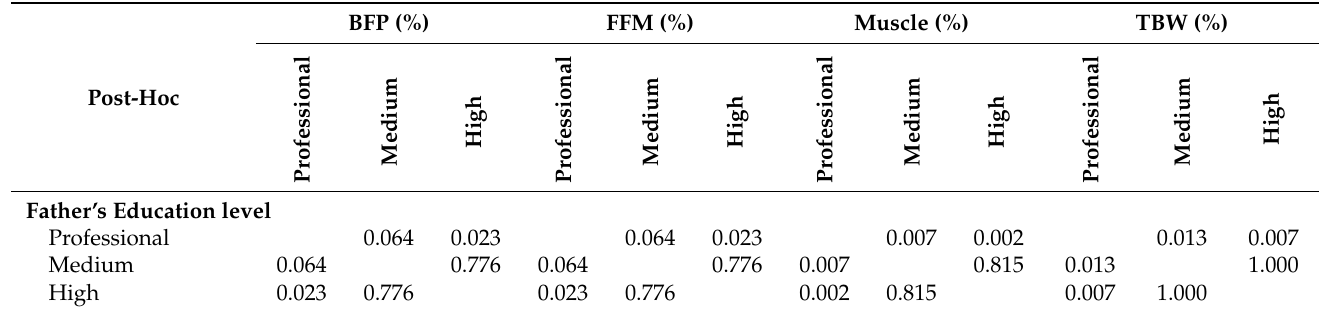
Table 7. The post-hoc test in reference to the difference between the body build parameters in relation to education of fathers.